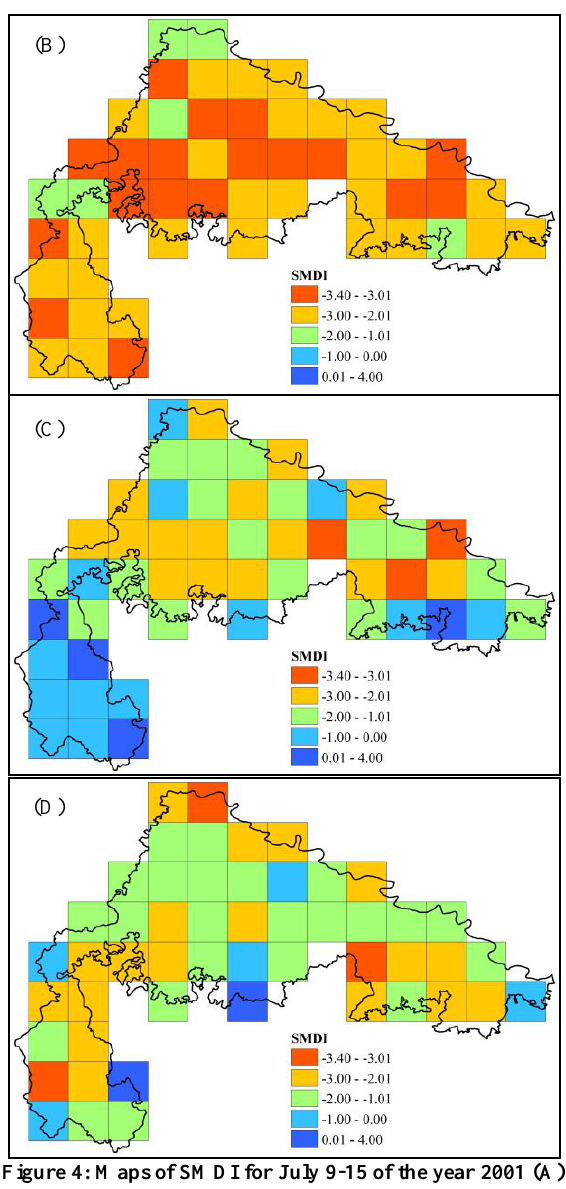
Figure 4: Maps of SMDI for July 9-15 of the year 2001 (A), 2002(B), 2009(C) and 2010(D)